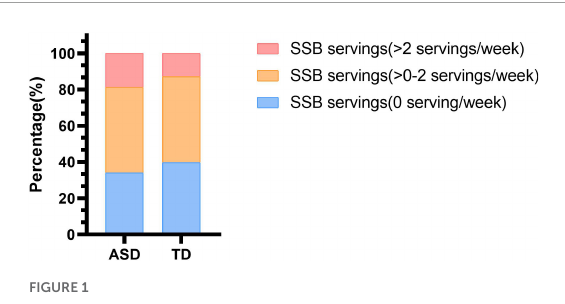
FIGURE1 Sugar-sweetened beverage consumption in children with ASD and TD children. SSB, sugar-sweetened beverage; ASD, autism spectrum disorder; TD, typically